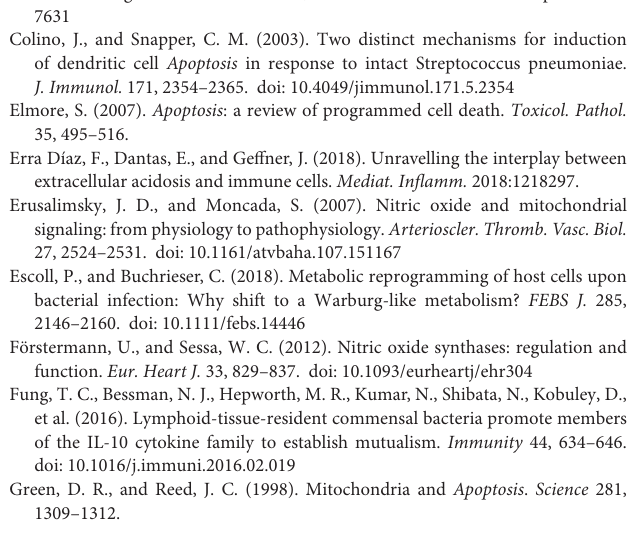
Supplementary Figure 1 | Similar changes in markers for phagocytosis and activation of BMDCs induced by A. faecalis or E. coli. BMDCs were co-cultured without (None) or with live A. faecalis or E. coli at 10 MOI for 24 h. (A) Rab7 and Lamp-1 gene expression were measured by RT-qPCR. (B) MHCII expression was measured by FACS. The results shown are representative of two independent experiments. Supplementary Figure 2 | FACS histogram of iNOS expression. As shown in Figure 1B , BMDCs were co-cultured without (None) or with live A. faecalis or E. coli at 10 MOI for 24 h and then iNOS expression was measured by intracellular FACS. The representative histograms are shown. Supplementary Figure 3 | Degrading of NO by A. faecalis. A. faecalis (1 × 10 8 , 3 × 10 8 , 1 × 10 9 CFU/well) was incubated with 100 µ M NOR3, a NO inducing reagent, at 37 ◦ C for 1 h. After the incubation, the concentration of NO was measured by Griess reagent kit. The results shown are representative of two independent experiments. Supplementary Figure 4 | BMDCs were co-cultured without (None) or with live E. coli at 10 MOI in the absence (None) or presence of A. faecalis LPS at 0.1 µ g/ml for 24 h, after which intracellular NO was measured by an OxiSelect Intracellular Nitric Oxide Assay Kit. BMDCs were stained with NO probe and the fluorescence was measured. The results shown are representative of two independent experiments. Supplementary Figure 5 | Little influence of treatment of SEIT or LPS on ECAR of BMDCs carrying A. faecalis or E. coli. (A) BMDCs were co-cultured without (None) or with live A. faecalis or E. coli at 10 MOI for 24 h in the absence or presence of the iNOS inhibitor SEIT and then extracellular acidification rate (ECAR) was measured by flux analyzer. (B) BMDCs were co-cultured without (None) or with live A. faecalis at 10 MOI for 24 h in the absence (None) or presence